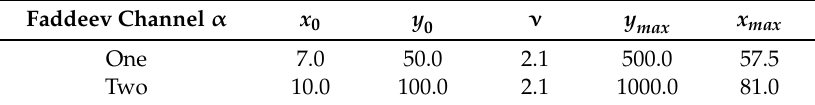
Table 2. Properties of the first resonance.